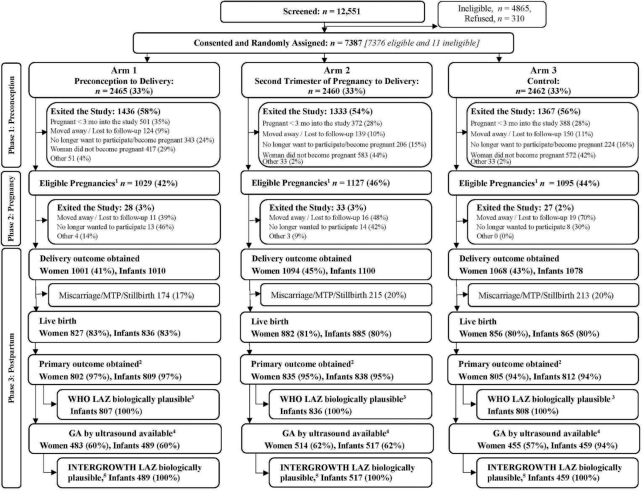
CONSORT diagram. Overall screening, random assignment, and obtainment of primary outcome by treatment arm. 1Percentage of those randomly assigned. Excludes women who became pregnant <3 mo into the study. The women who had eligible pregnancies may have had delivery data obtained or they may have exited the study before delivery. 2Primary outcome was obtained for live newborns with 3 length measurements taken within 48 h of delivery. Among women, primary outcome obtained from ≥1 infants of the woman. 3LAZ for birth length, based on actual birth length measured by 48 h of age, calculated using the expanded tables of the Child Growth Standards published by the WHO (30) that provide scores by day of measurement. The same standards were used to calculate the weight-for-age, head circumference-for-age, and BMI-for age z scores (WAZ, HCAZ, and BMIAZ). 4GA at birth is defined as the age at the time of the ultrasound based on the ultrasound plus time until birth if the ultrasound was done between 6 wk + 0 d and 13 wk + 6 d and the GA at birth was between 24 wk + 0 d and 42 wk + 6 d. If the ultrasound was not conducted during the GA previously mentioned, then the GA at birth is missing. 5LAZ, WAZ, HCAZ, and weight to length-ratio-for age (WLRAZ) z scores and percentiles based on measurements within 48 h of delivery are calculated using the INTERGROWTH-21st International Standards for Newborn Size (32) and International Standards for Newborn Size for Very Preterm Infants (33), which provide z scores by sex and GA at birth for infants between 33 wk + 0 d and 42 wk + 6 d GA at birth and between 24 wk + 0 d and 32 wk + 6 d GA at birth, respectively. CONSORT, Consolidated Standards of Reporting Trials; GA, gestational age; LAZ, length-for-age z score; MTP, medical termination of pregnancy.